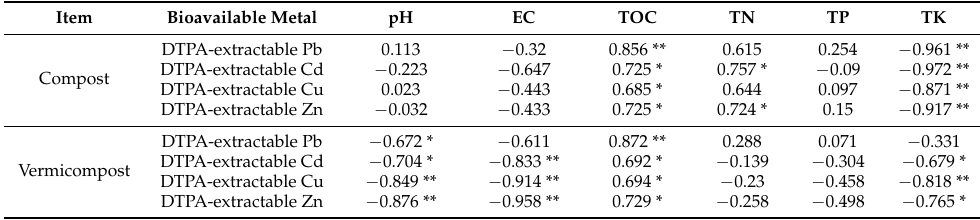
Table 3. Pearson correlation between DTPA-extractable heavy metals and the physicochemical indices of sludge during composting and vermicomposting. Item Bioavailable Metal pH EC TOC TN TP TK DTPA-extractable Pb 0.113 − 0.32 0.856 ** 0.615 0.254 Compost DTPA-extractable Pb − 0.672 * − 0.611 0.872 Vermicompost